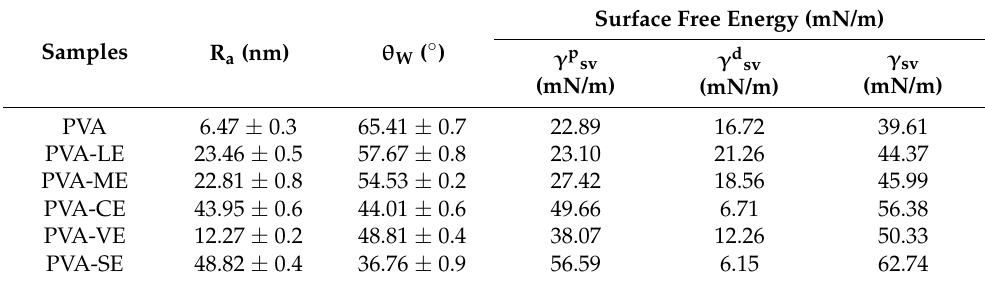
Table 2. Roughness (R a ), contact angle ( θ W ), surface free energy ( γ sv ) and its dispersive ( γ d sv ) and polar ( γ p sv ) components for PVA and PVA films loaded with plant extracts.